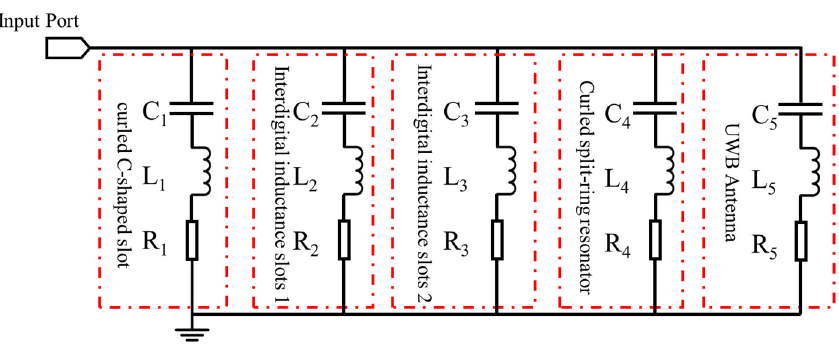
Figure 7. Equivalent circuit model of the proposed band-notched UWB antenna.